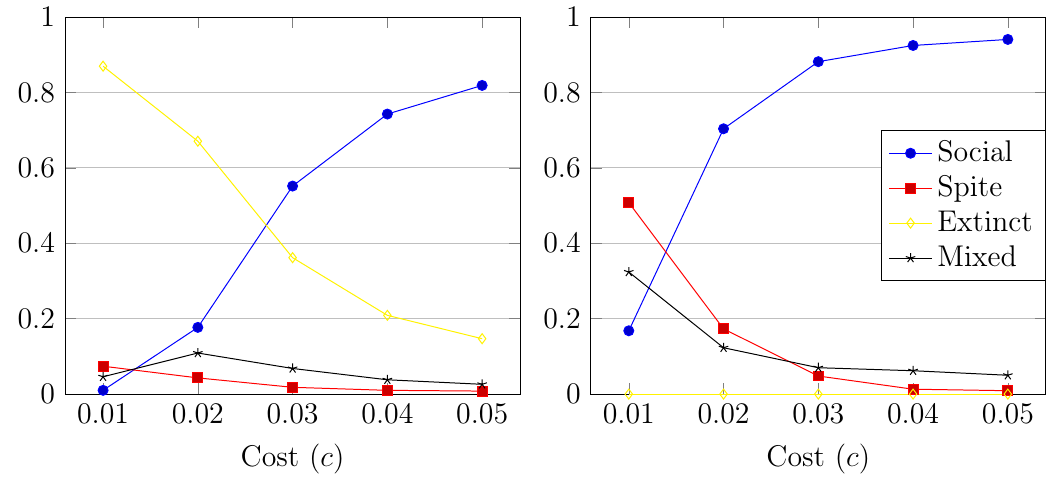
Figure 1: Proportion of simulation runs that are predominated by a particular strategy or go extinct after 10,000 generations for different values of c. For all simulations b = 0 . 7. Left panel shows carrying capacity ρ = 100 and right panel shows ρ =